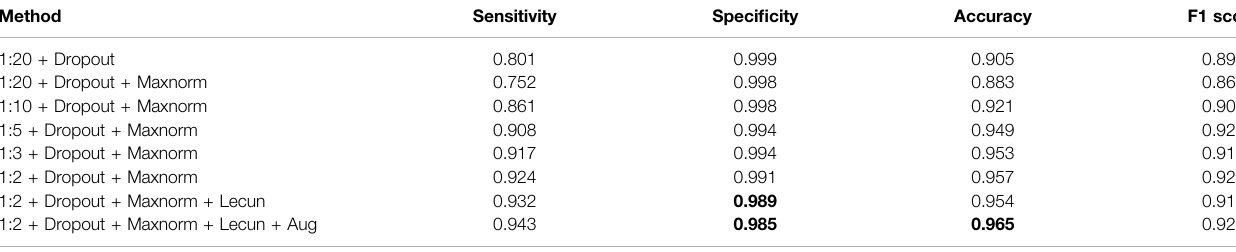
TABLE 2 | The classi fi cation results and network parameters on NLST test set.